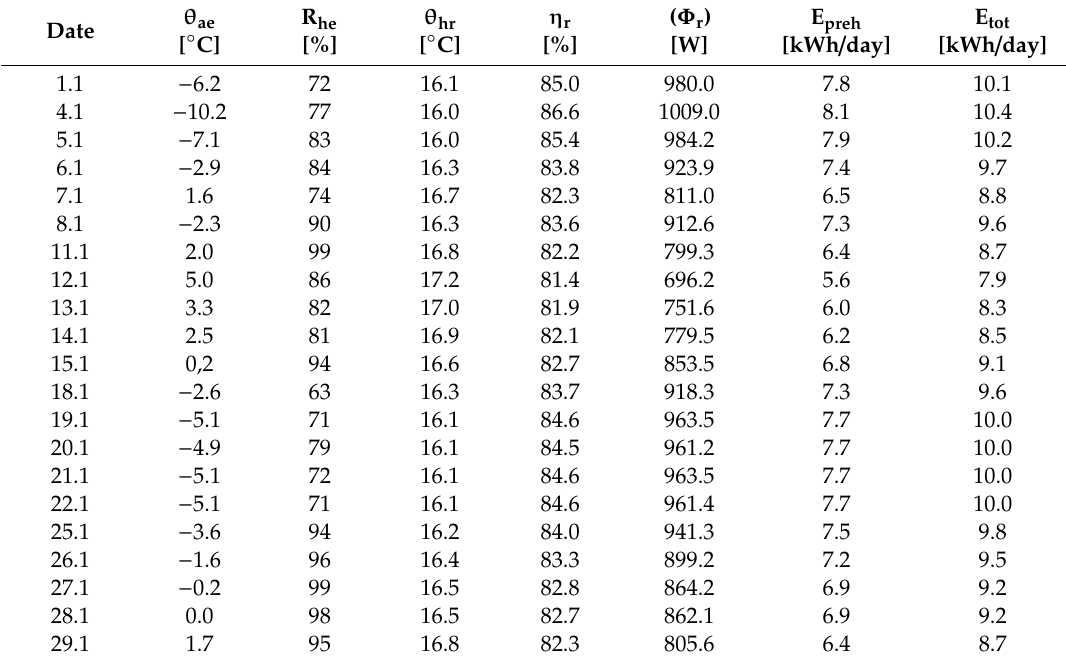
Table 2. Input physical parameters for energy performance